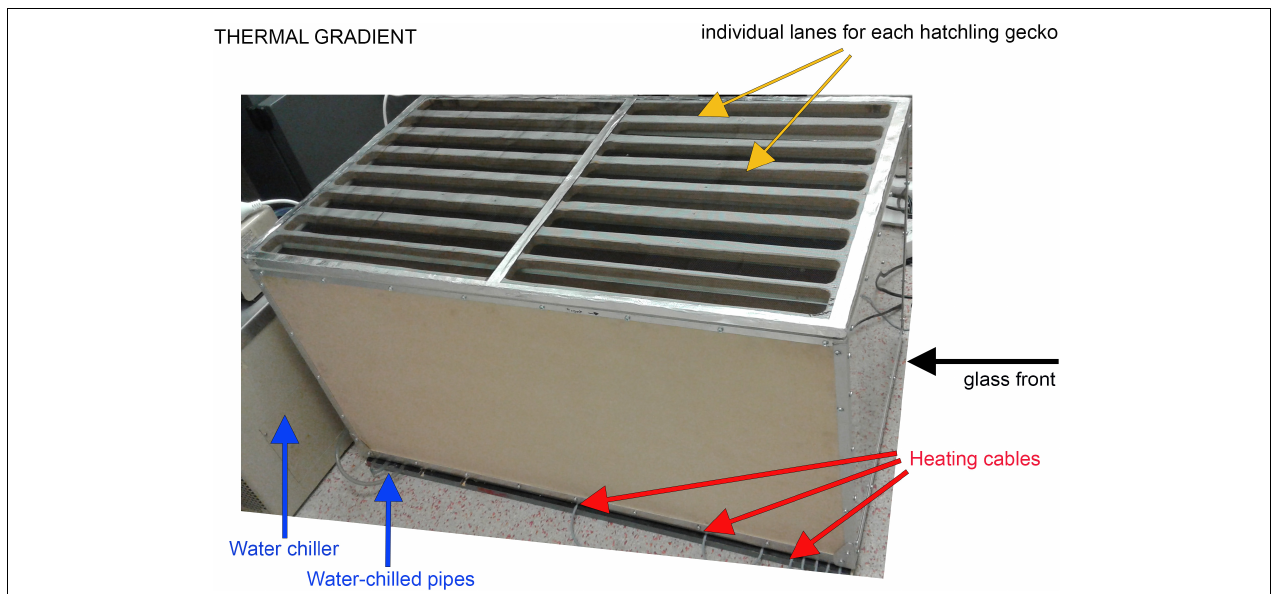
FIGURE 2 | Photograph of the thermal gradient used to measure preferred body temperatures of hatchling velvet geckos. Each gecko was placed in a separate runway, which contained a plastic half pipe for shelter, and a water dish. Two 250-watt infrared lamps provided additional heating at the hot end (not shown in the